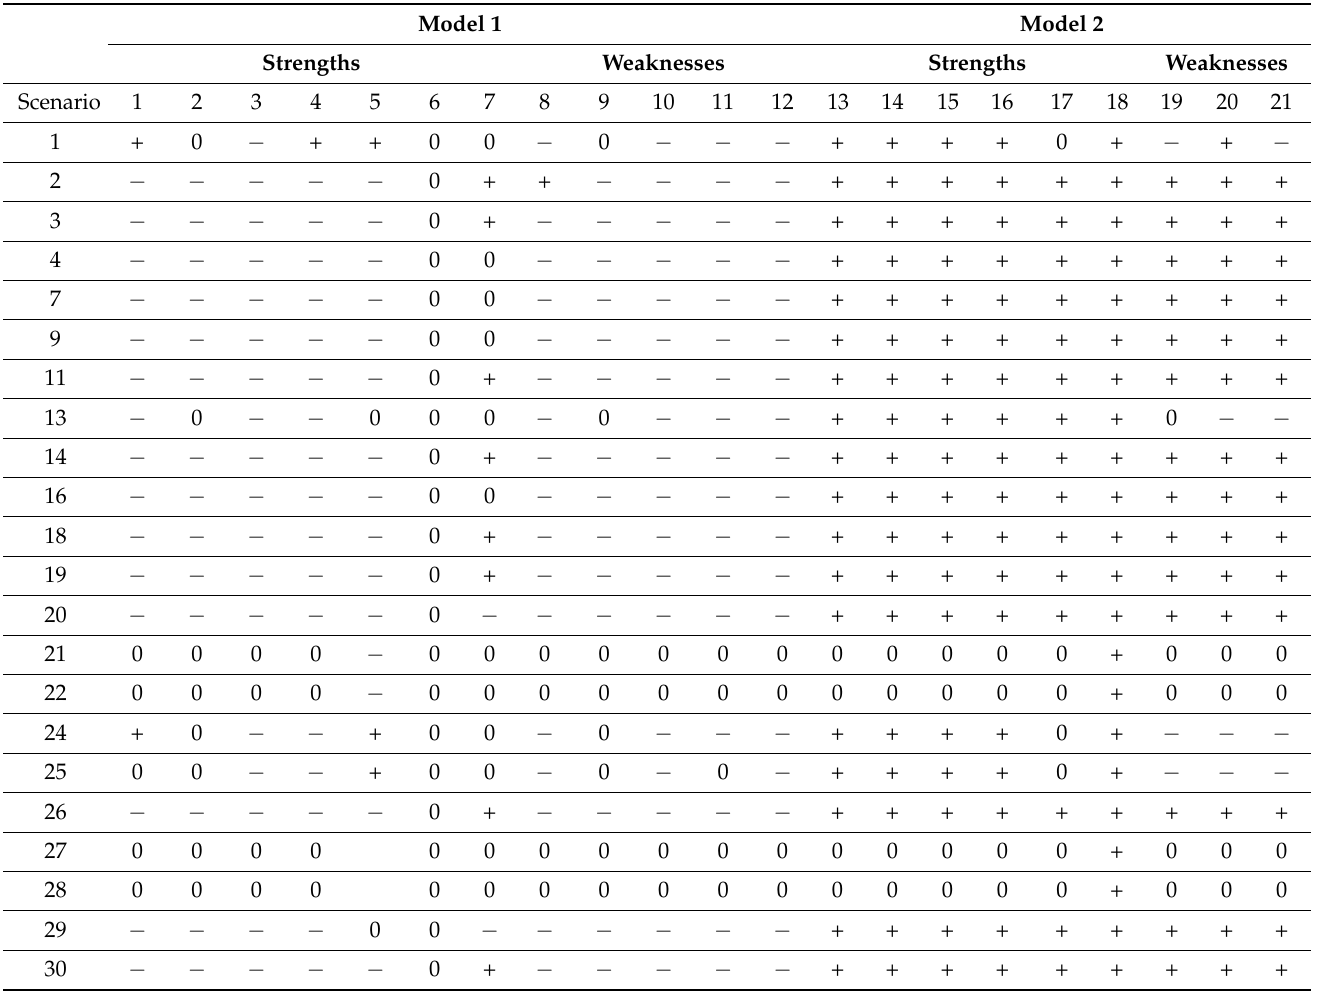
Table 3. Results of model 1 and model 2 for local